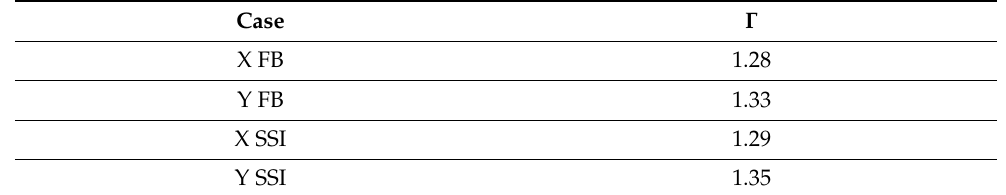
Figure 17. Graphical representation of the N2 method for PGA 0.215 g and for FB ( a ) and SSI ( b ). Table 14. Values of transformation factors.